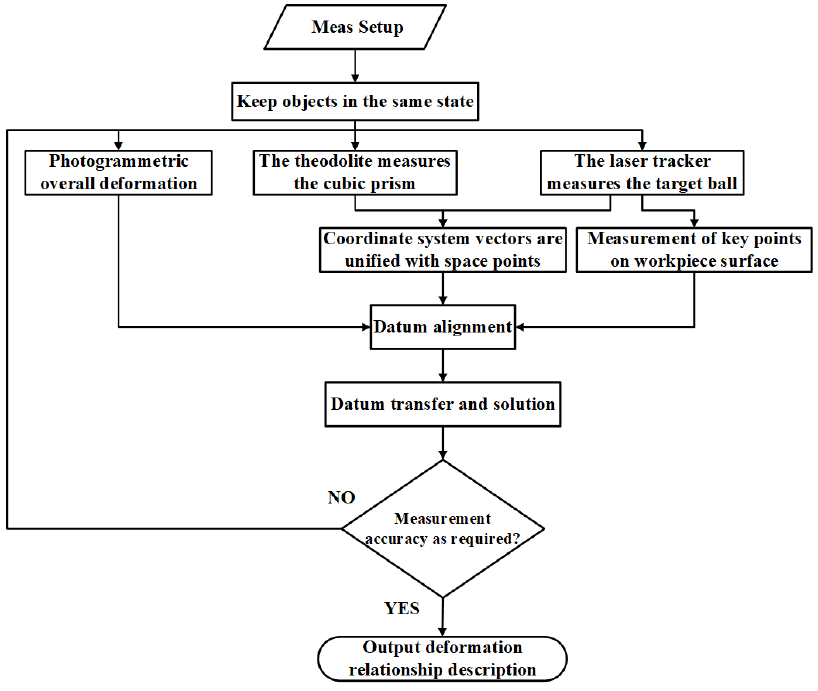
Figure 15. Experimental flow diagram.